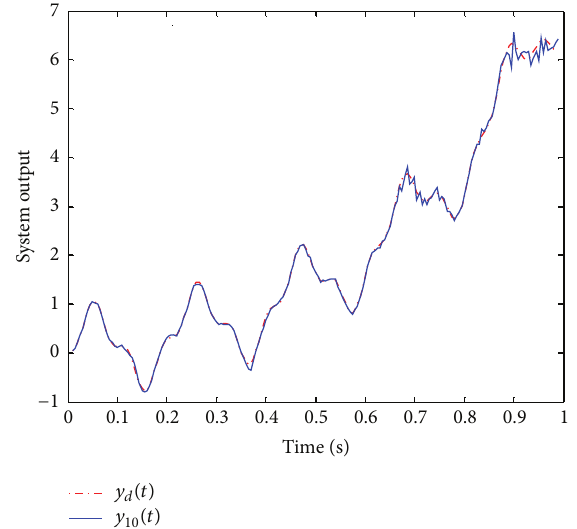
Figure 1: The random switched rule 𝜎(𝑡) for system (64).